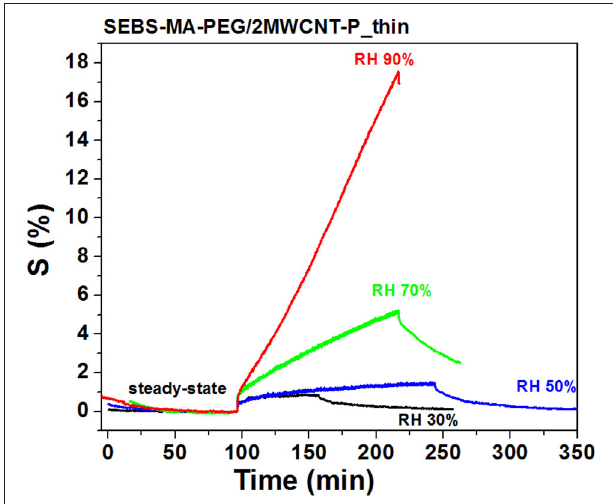
FIGURE 10 | Responses of SEBS-MA-PEG/2MWCNT-P thin samples ( 0.1mm) to 30, 50, 70, and 90 % RH during extended exposure ∼